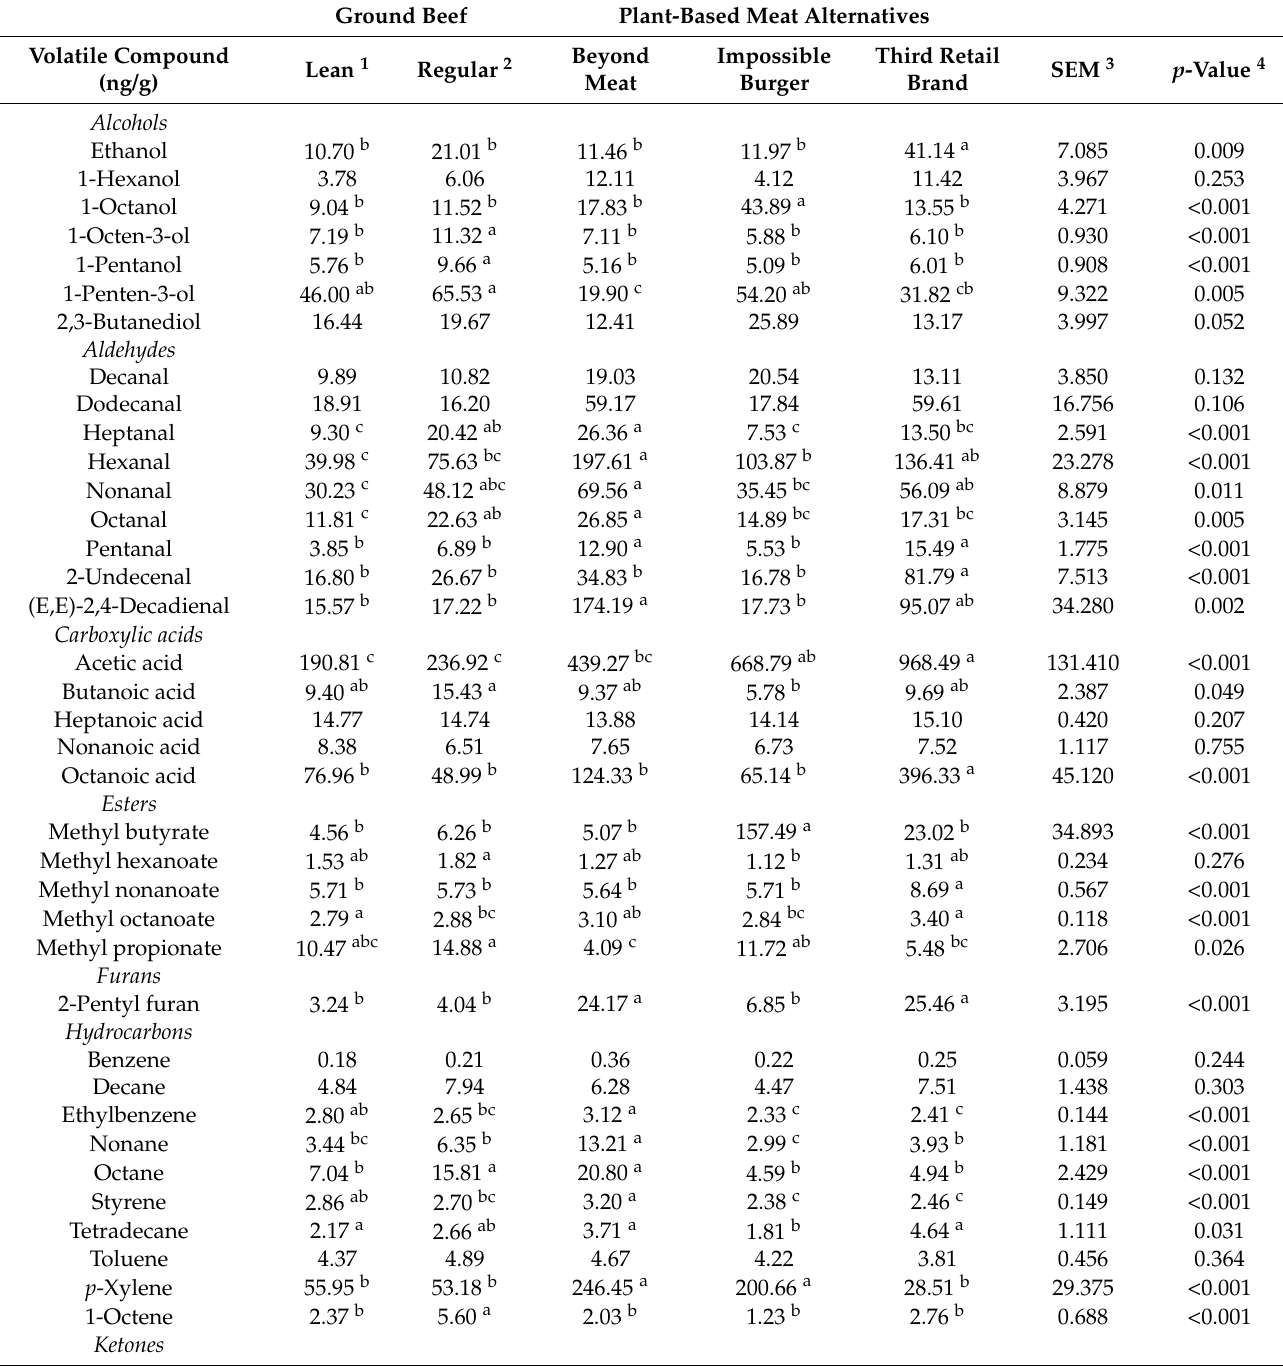
Table 4. Least squares means of volatile compound concentration from three plant-based meat alternatives and two lean levels of ground